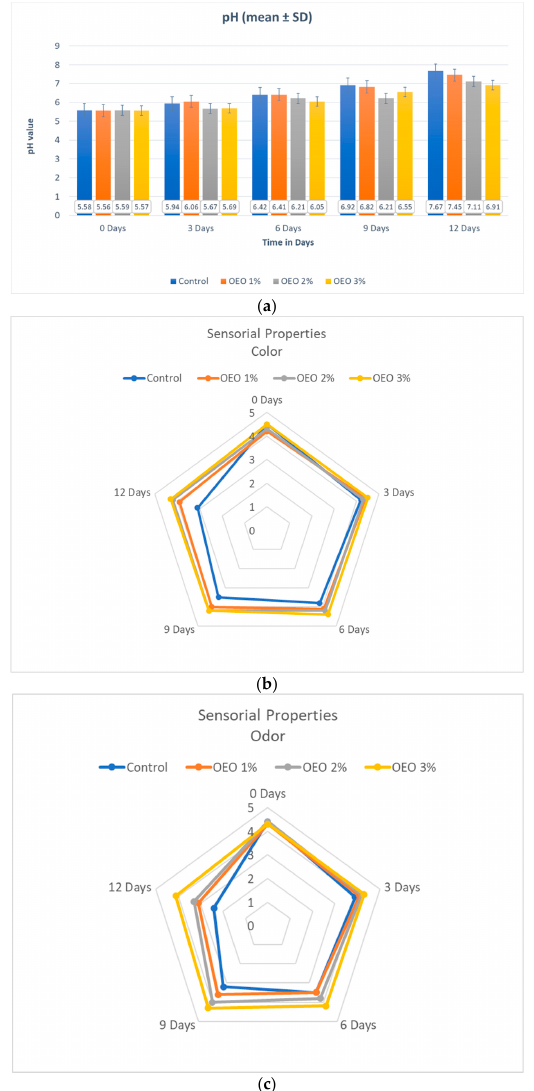
Figure 1. ( a ) pH values; ( b ) sensorial properties color scale: 5 reddish brown, 4 bright red, 3 pinkish red, 2 pink, 1 pale pink; and ( c ) sensorial properties odor scale: 1 very unpleasant, 2 unpleasant, 3 acceptable, 4 pleasant, 5 very pleasant on minced beef meat treated with edible coating stored at 4 °C for 12 days. OEO: Oregano essential oil.